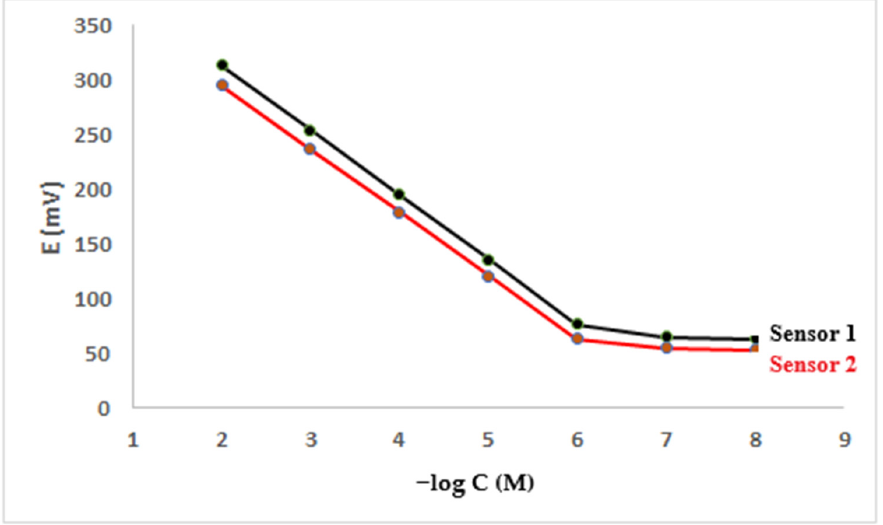
Figure 3. Profile of the potential (in mV) versus − log concentration (in M) for MOX sensors at pH 3.